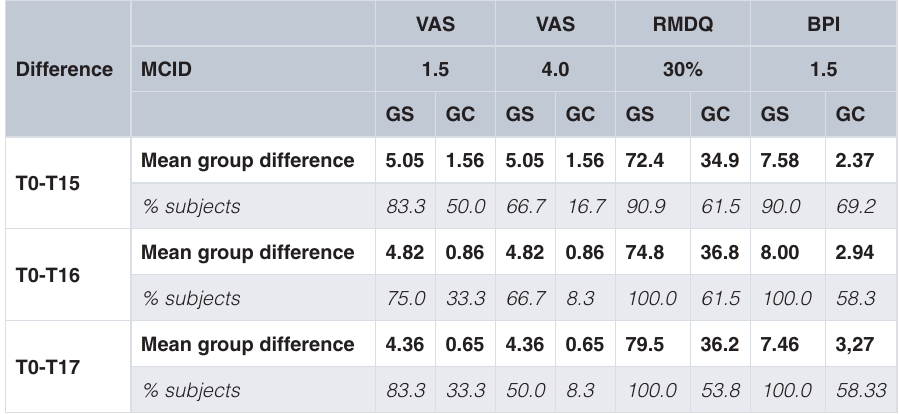
Table 3. Clinical significance for measured outcomes as mean differences and percentage of